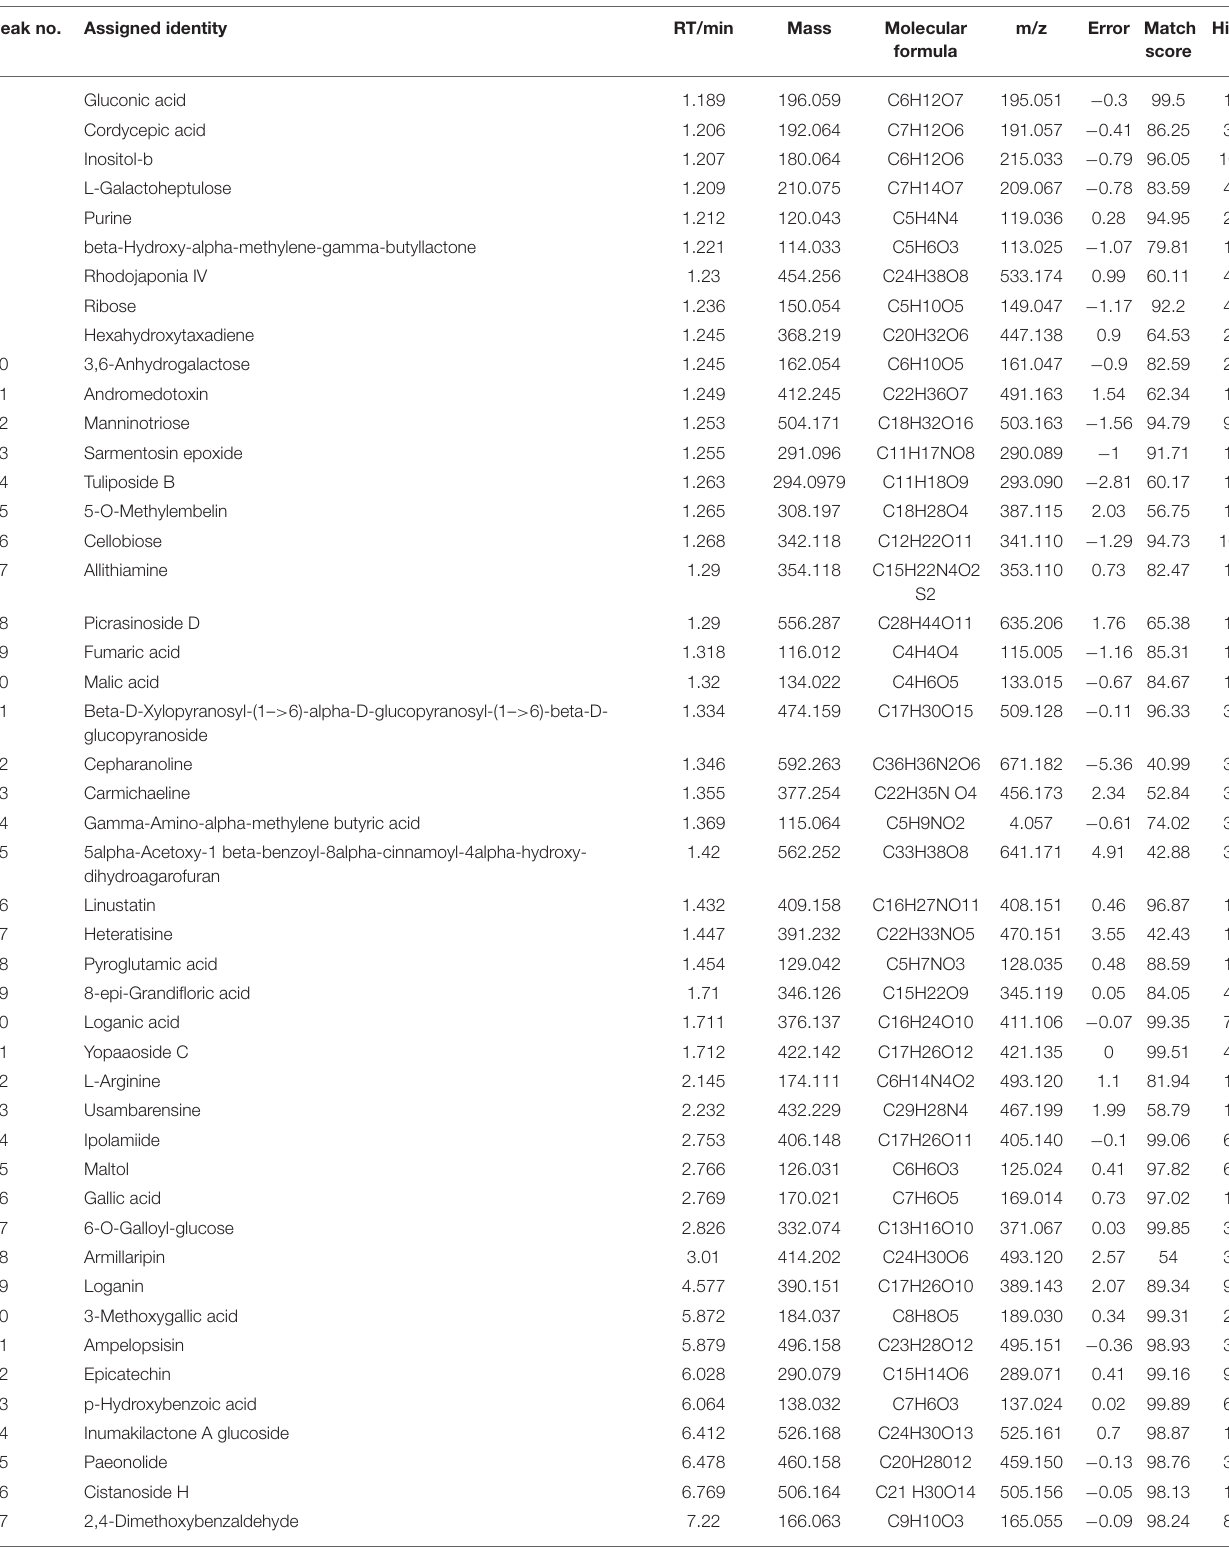
TABLE 3 | Metabolites identified from the Moutan cortex radicis . Peak no. Assigned